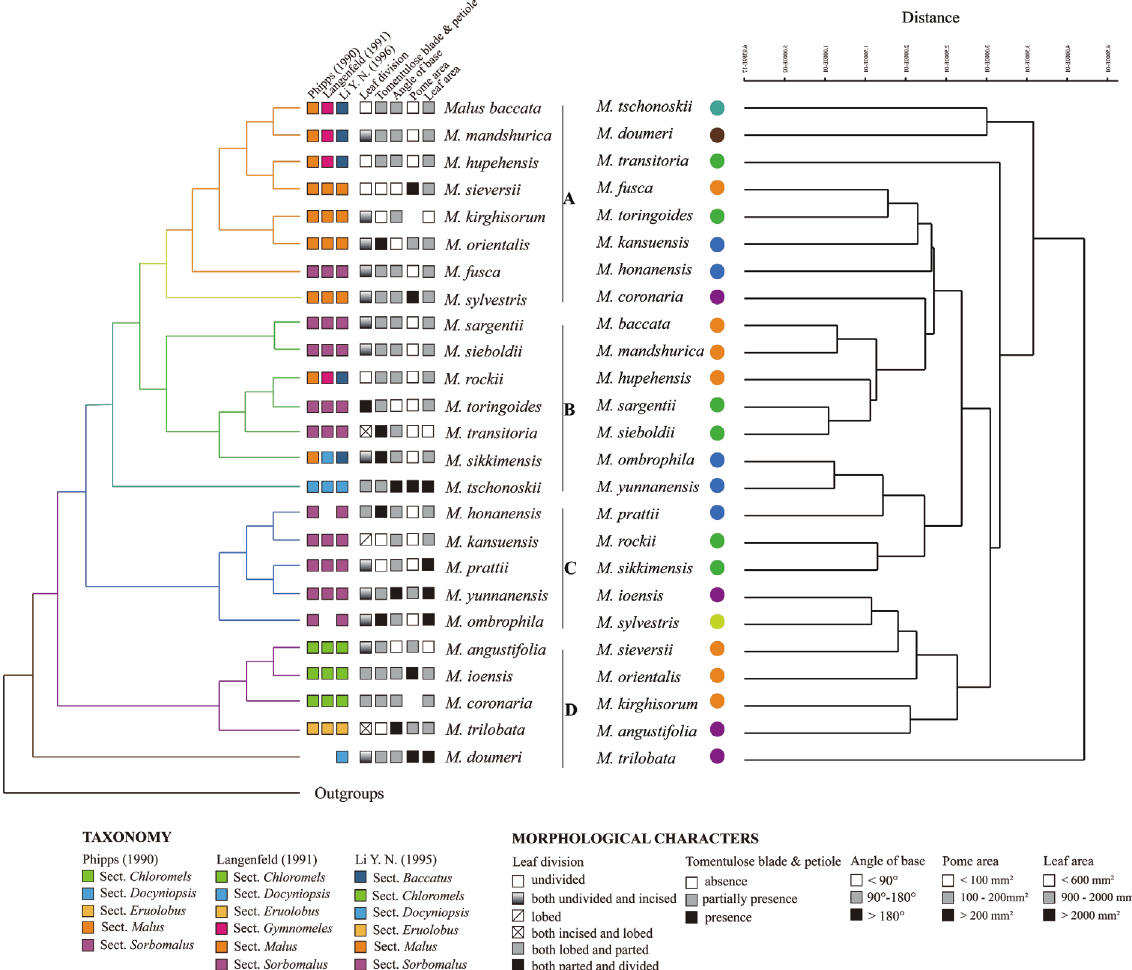
Fig. 61. Mapping the informative characters and traditional taxonomy systems by Phipps (1990), Langenfeld (1991) and Li (1996) on the most recent phylogenetic tree (adapted from Jin, 2014). The UPGMA tree used for comparison is marked with the colour of the corresponding branch. The rest of the information is presented in the